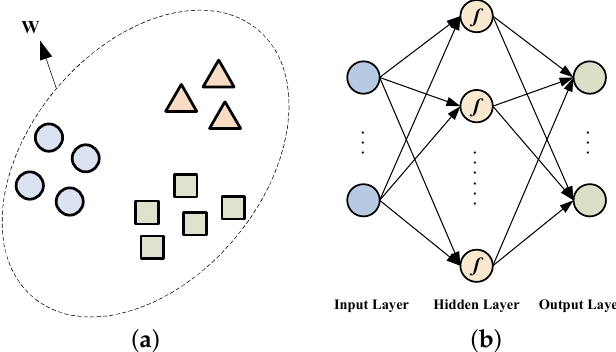
Figure 1. Graphical illustrations for the methodologies in the related work: ( a ) principal projection direction of principal component analysis; and ( b ) network structure of extreme learning